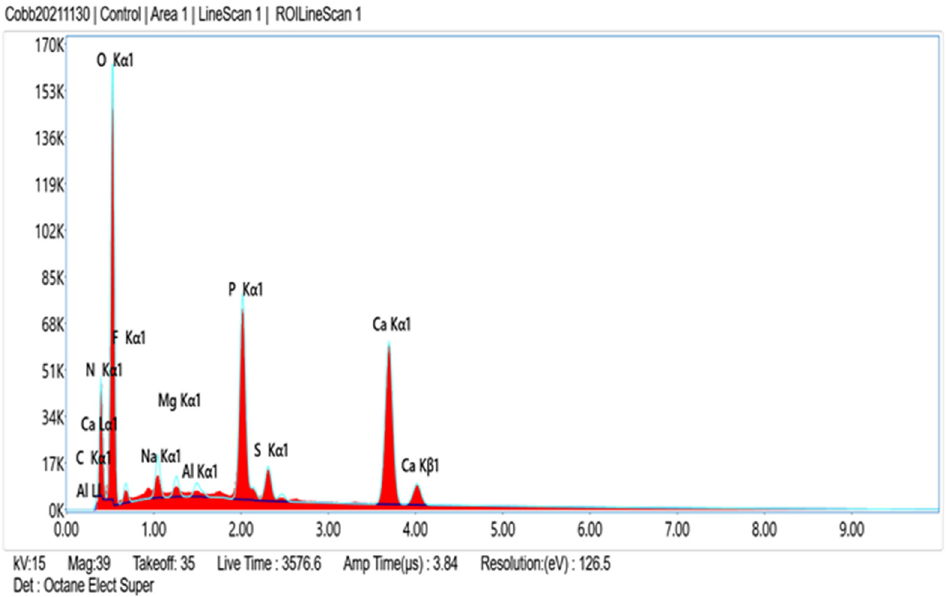
Figure 10. Conversion of the line scan seen in Figure 9 (SRP only specimen) to an EDS spectrum shows relative peak height of the various elements of interest. Dominate peaks are O, P, and Ca and lesser peaks for N, F, Na, Mg, and S. Peaks for Al and C are likely derived from the carbon sputter coating and aluminum mounting stub.